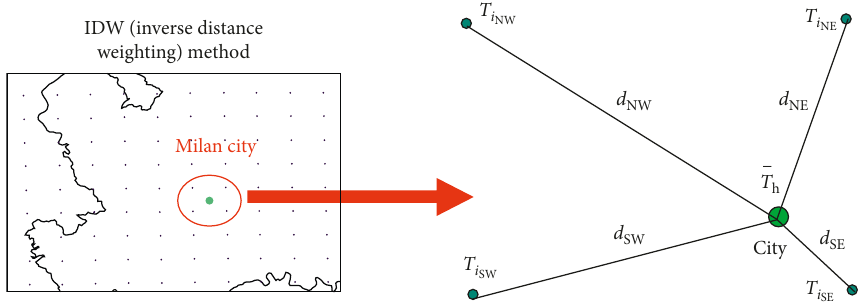
Figure 2: Procedure to calculate the hourly spatial mean temperature forecast ( T